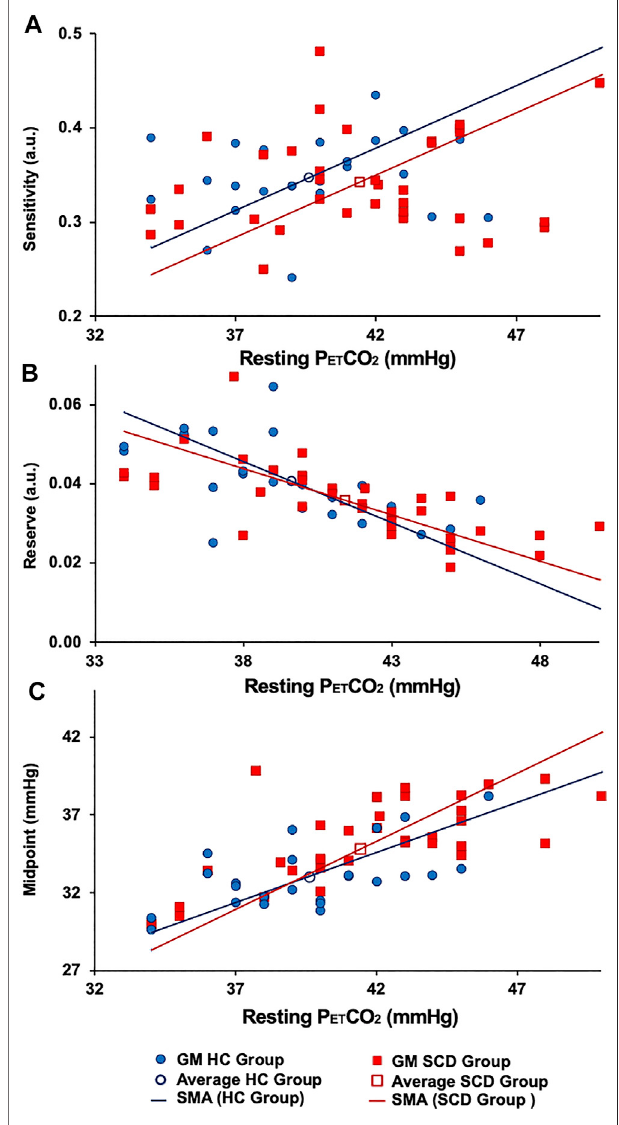
FIGURE 5 | The (A) resting resistance sensitivity, (B) resting resistance reserve. (C) Resting resistance midpoint in GM HC (blue lines) and GM SCD (red lines).Note:thedifferenceintheaveragerestingmidpointsbetweenthetwogroups.